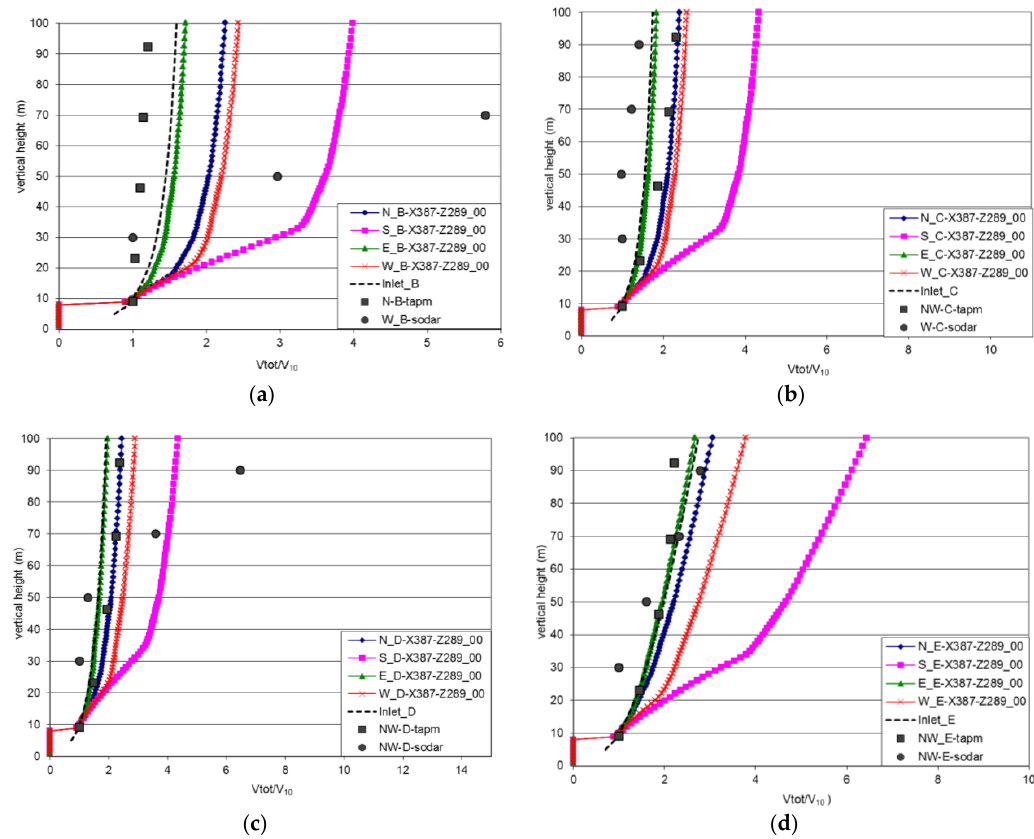
Figure 4. CFD calculations (“-X387-Z289_00”), mesoscale calculations (“-tapm”) and measurements (“-sodar”) of vertical profiles of wind speed over position 2 (Figure 1) for the following: ( a ) unstable (B), ( b ) unstable (C), ( c ) neutral (D) and ( d ) stable (E) conditions (Table 1 ). COST 710 inlet profiles (“ - Inlet_”B,C,D, E) are also shown.